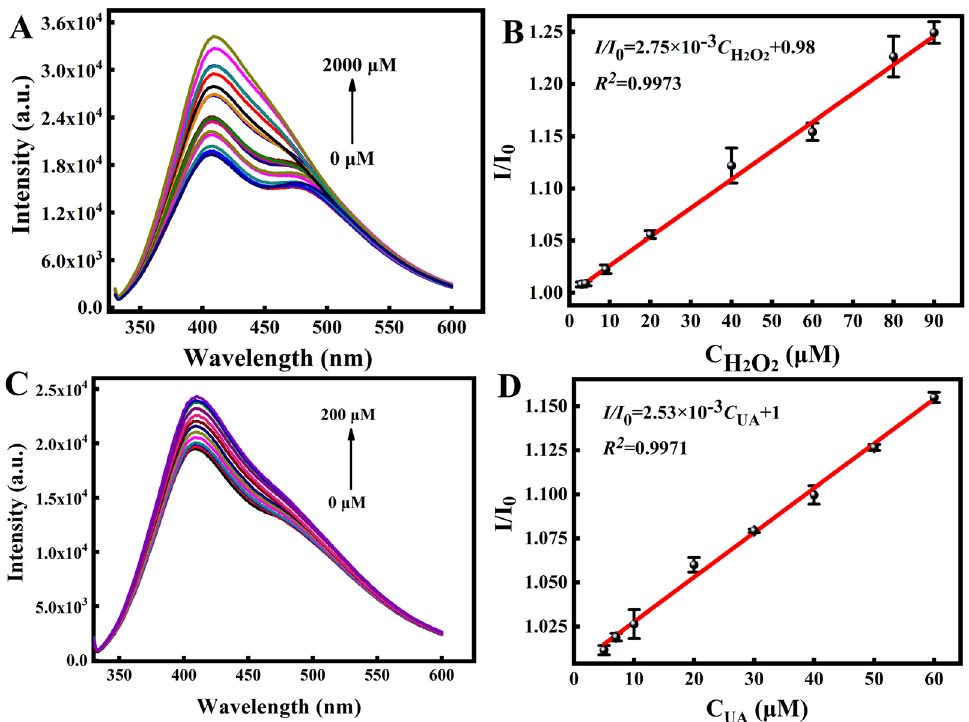
Figure 6. ( A ) Fluorescence spectra of the AgNPs/N-CQDs in the presence of H 2 O 2 at concentrations of 0–2000 μ M (excitation: 340 nm). ( B ) Dependence of I / I 0 on the concentration of H 2 O 2 . ( C ) Fluorescence spectra of the AgNPs/N-CQDs in the presence of UA at concentrations of 0–200 μ M (excitation: 340 nm). ( D ) Dependence of I / I 0 on the concentration of UA. The data are averages of five measurements and the error bars are standard deviations. Table 1. Comparison of developed methods previously reported methods in terms of the response range and LOD.